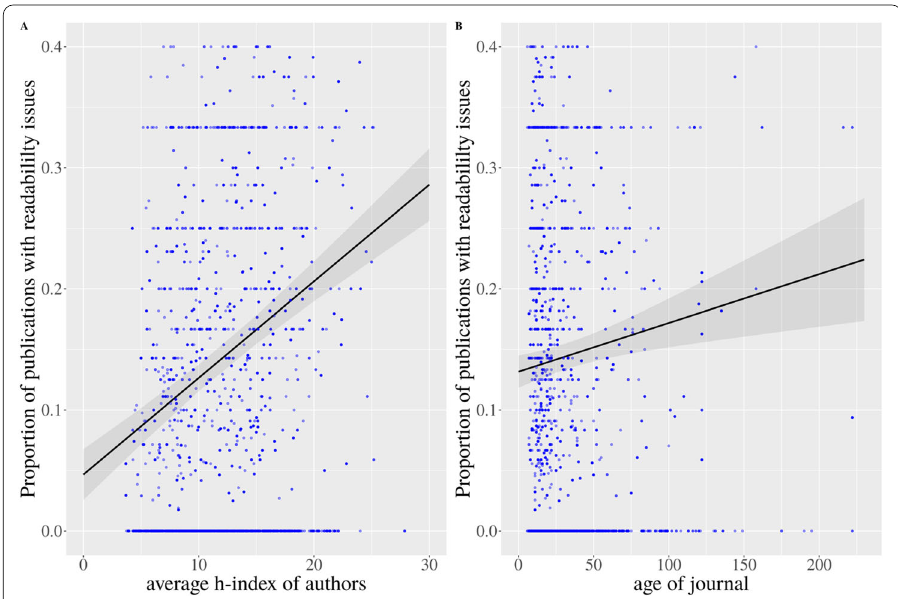
Figure 6 Statistically significant marginal effects on journals’ proportion of publications with readability issues. ( A ) journal average author h-index’s marginal effect. ( B ) journal age’s marginal